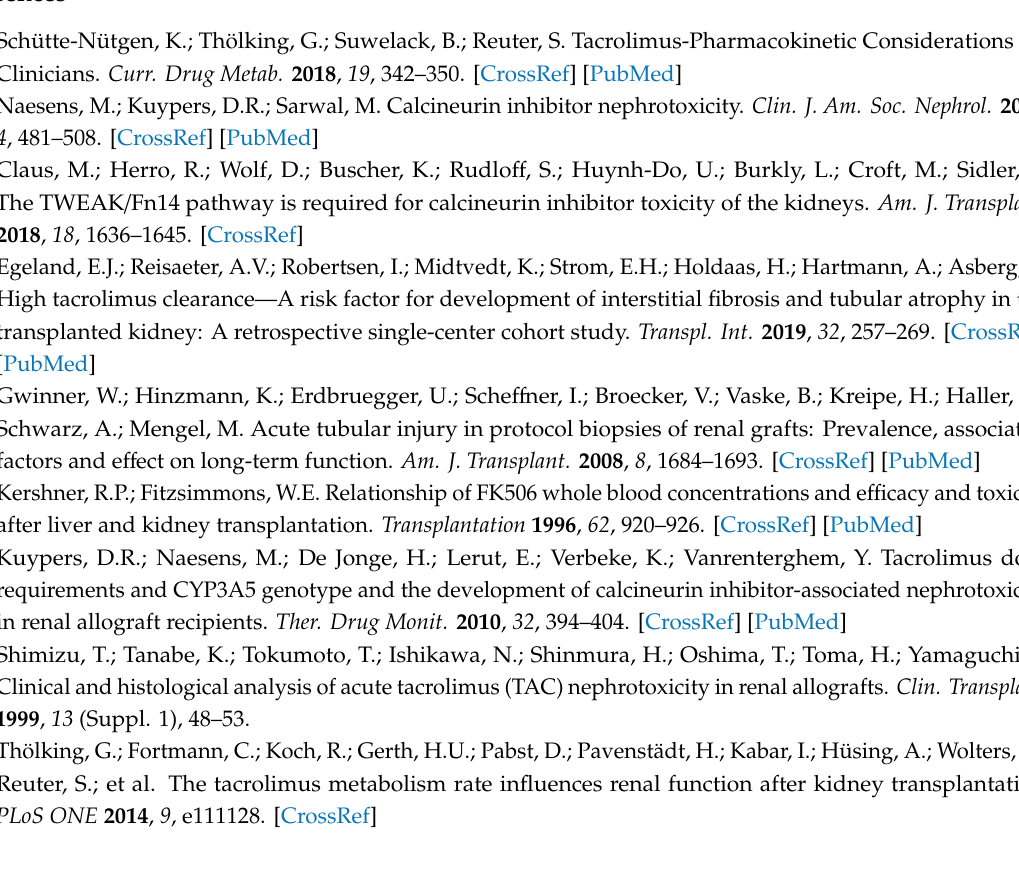
Figure S1: PK profiles used for NRK cell incubation, Table S1: Patient characteristics: Pulse wave analysis, Table S2: Patient demographics: Glycocalyx